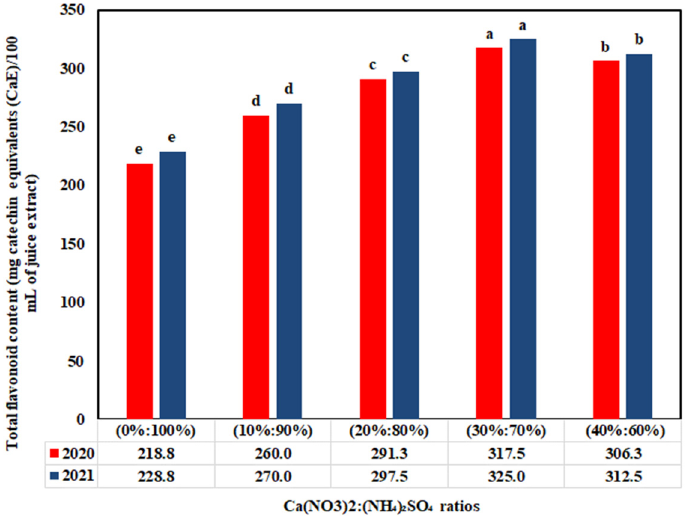
Figure 6. The impact of Ca(NO 3 ) 2 :(NH 4 ) 2 SO 4 ratios on total flavonoid content of the pomegranate fruits of cv. ‘Wonderful’ in 2020 and 2021 seasons. Significant differences ( p < 0.05) are denoted by values in the same column that are marked with distinct letters.